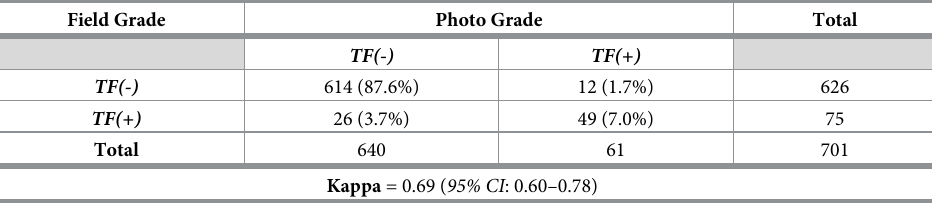
Table 2. Relationship between field and photo grading of trachoma in children ages 1–9 years (N = 701) a